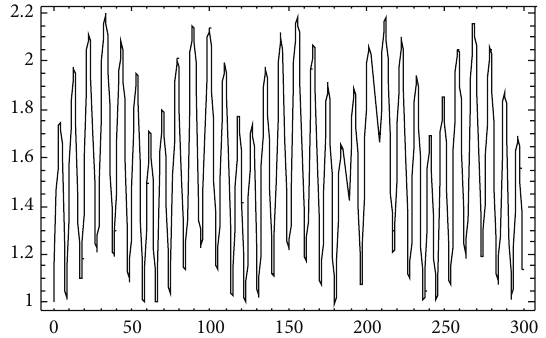
Figure 1: Phase plot of master system.